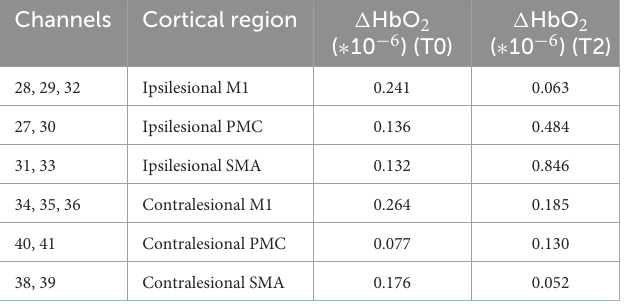
TABLE 3 Changes of HbO 2 concentration in cortical core motor